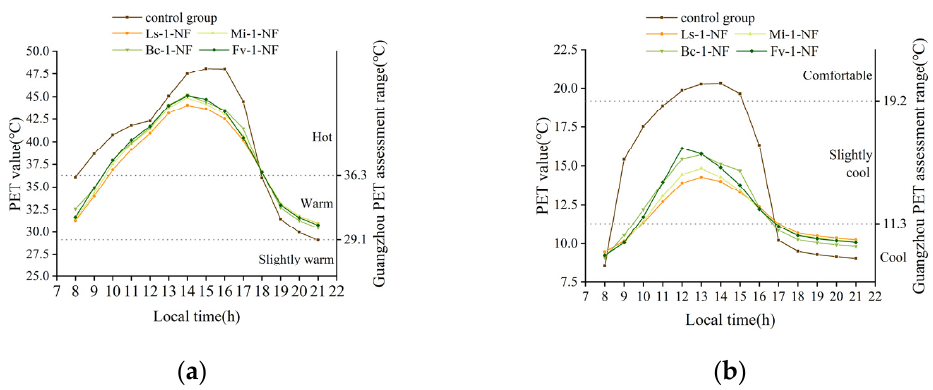
Figure 15. Effects of arbor species on outdoor thermal comfort in summer ( a ) and winter ( b ).